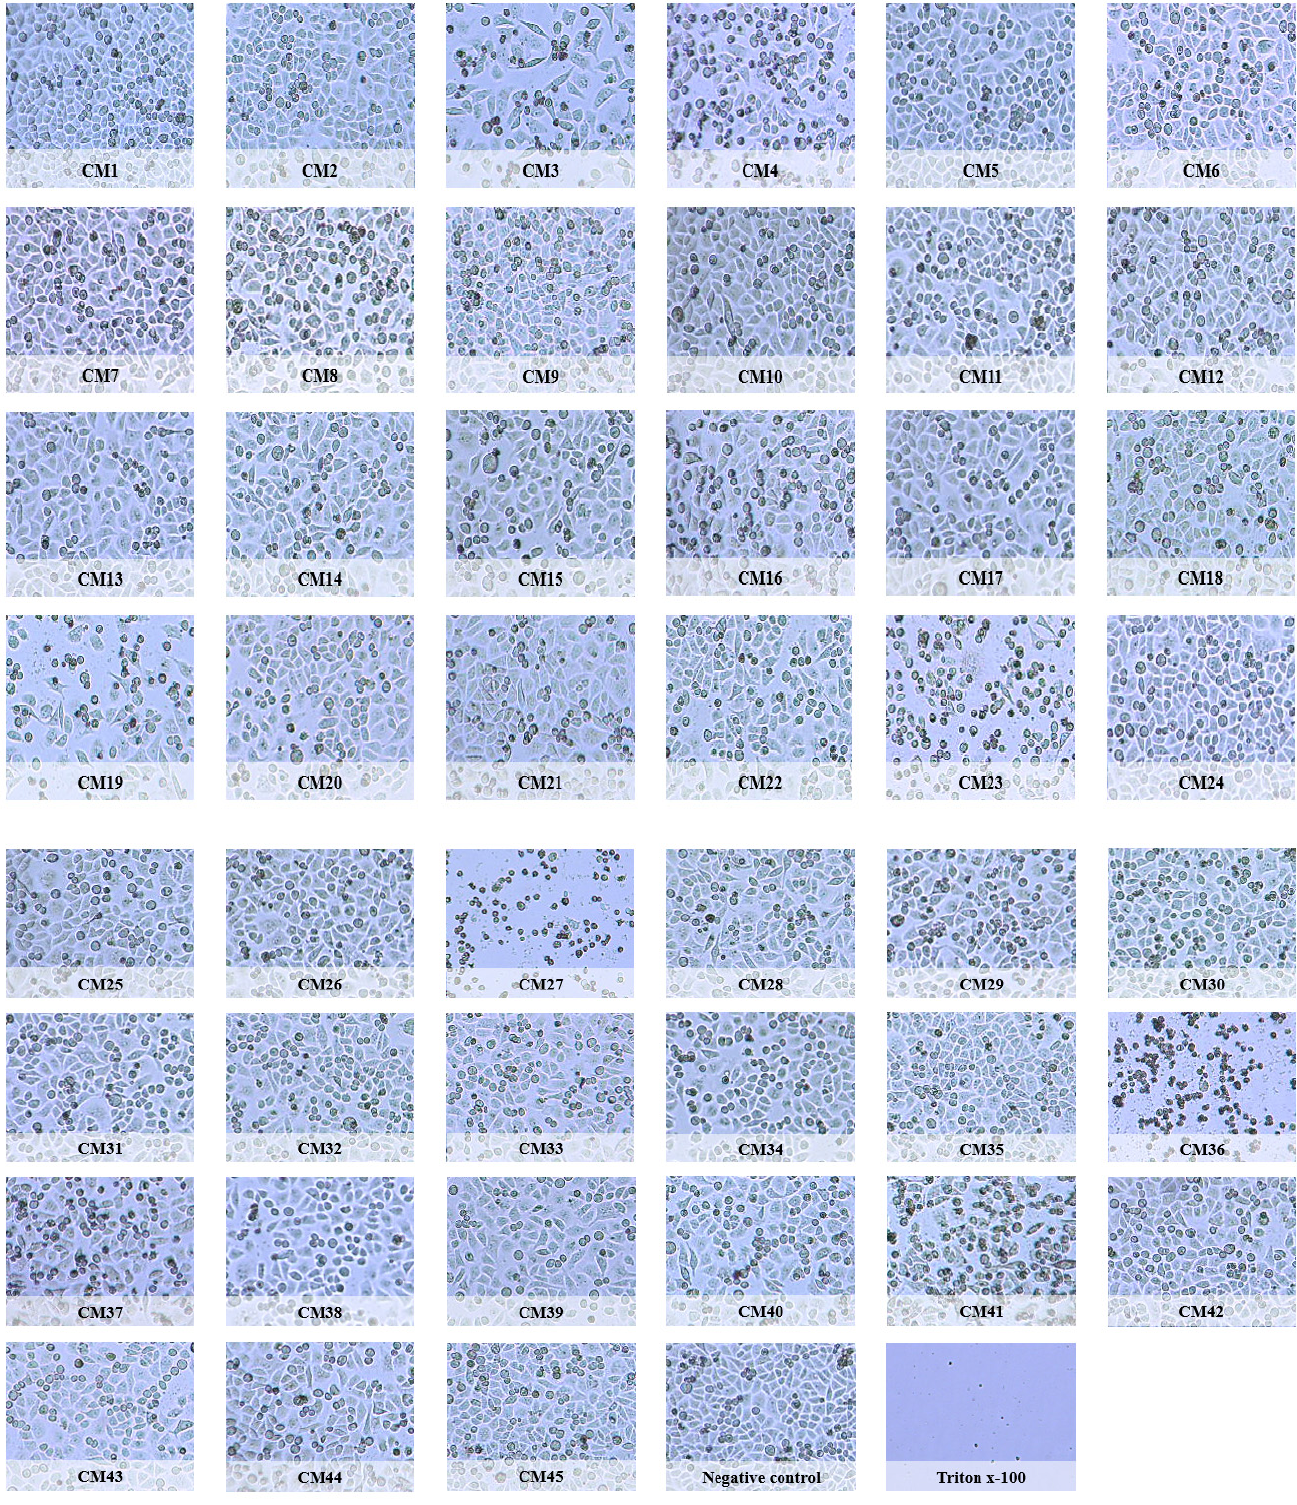
Figure 1. Representative images of cell survival assay results for HeLa cells treated with C. porosus conditioned media. HeLa cells were treated with 100 µL conditioned media from C. porosus for 24 h at 37 °C in carbon dioxide. Positive control cells were treated with Triton X-100. The cells were trypsinized and seeded into a new plate. Microscopic images were taken after 24 h using an inverted light microscope at ×40 magnification. [(CM1: D. grandis , CM2: O. intermedium , CM3: P. aeruginosa , CM4: B. sediminis , CM5: M. paraoxydans , CM6: E. tarda , CM7: A. hermannii , CM8: T. spumae , CM9: D. polyhydroxybutyrativorans , CM10: S. pasteuri , CM11: E. cloacae , CM12: C. yeoncheonense , CM13: B. aryabhattai , CM14: S. aureus ) from mouth and esophagus, (CM15: P. hauseri , CM16: H. paralvei , CM17: S. pasteuri , CM18: A. salmonicida , CM19: P. aeruginosa )